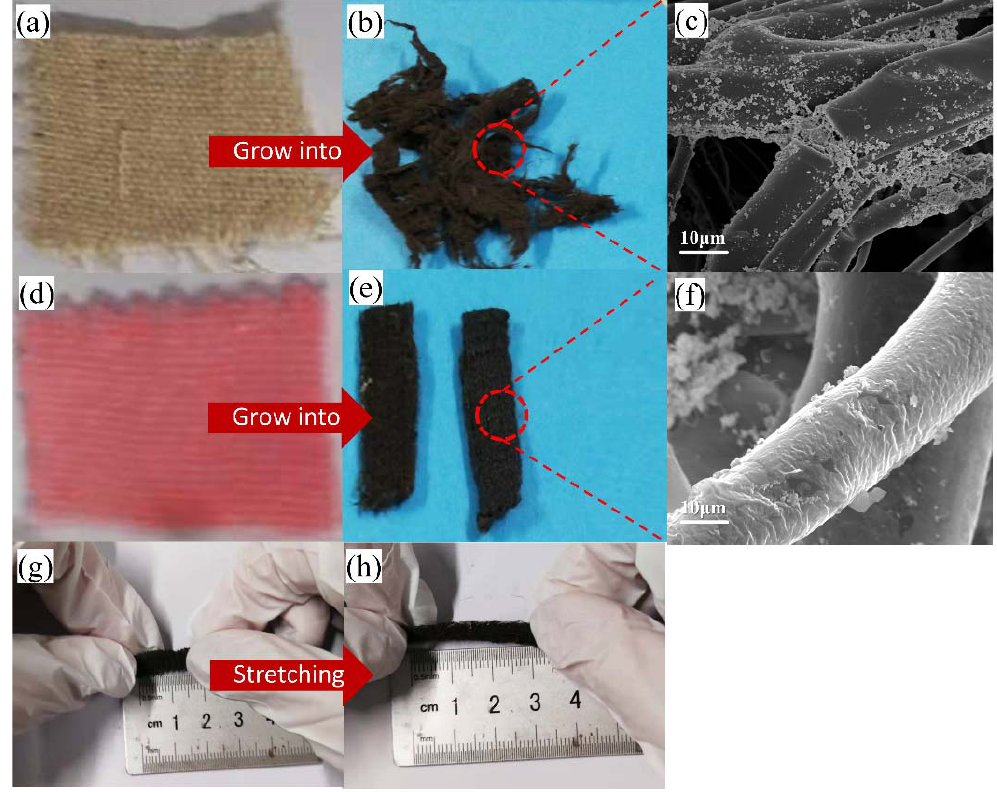
Figure 4. ( a ) The physical image of natural cotton and linen. ( b ) Conductive cotton and linen. ( c ) SEM image of conductive cotton and linen fiber. ( d ) The physical image of ribbed polyester fabric. ( e ) Conductive fabrics. ( f ) SEM image of conductive fabric fiber. ( g ) Conductive fabric before stretching. ( h ) The conductive fabric after stretching.